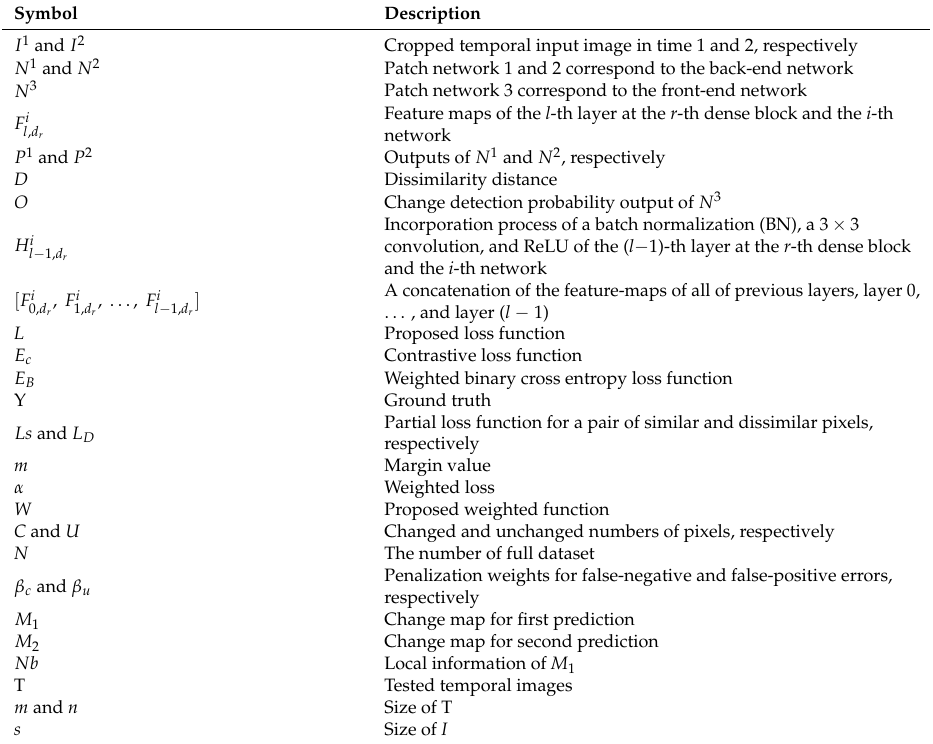
Table 1. Symbols used in the proposed fusion network for change